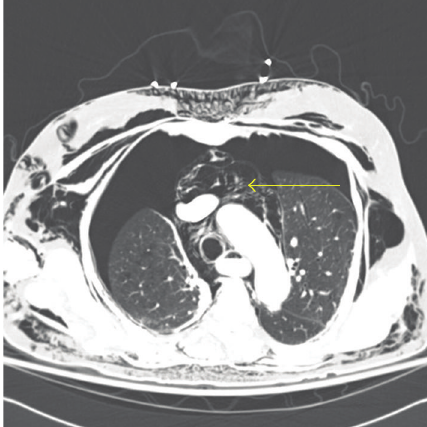
Figure 6: Transverse section of CT abdomen showing subcutaneous emphysema and